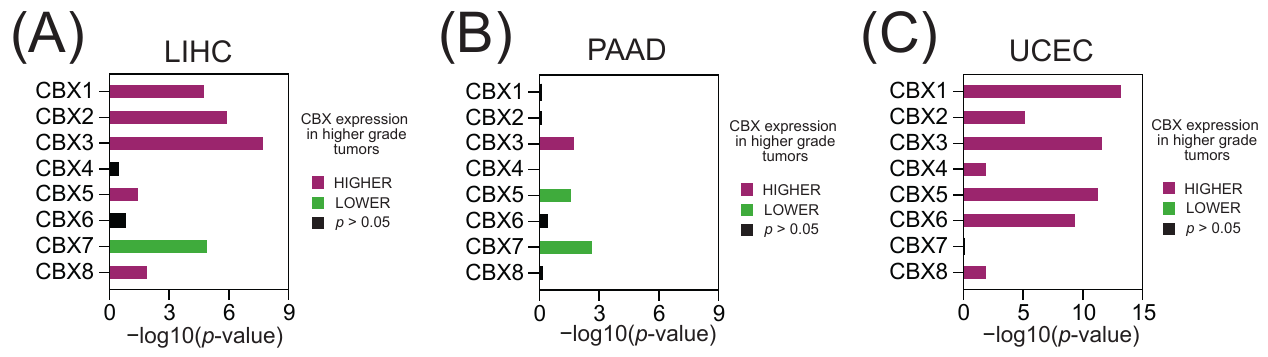
Figure 4. The association between CBX family members and tumor grade in selected TCGA tumors. The association between CBXs expression and tumor grade—either lower (green) or higher stage (purple), as determined with the Spearman correlation test ( − log10( p -value)) in ( A ) LIHC, ( B ) PAAD, and ( C ) UCEC